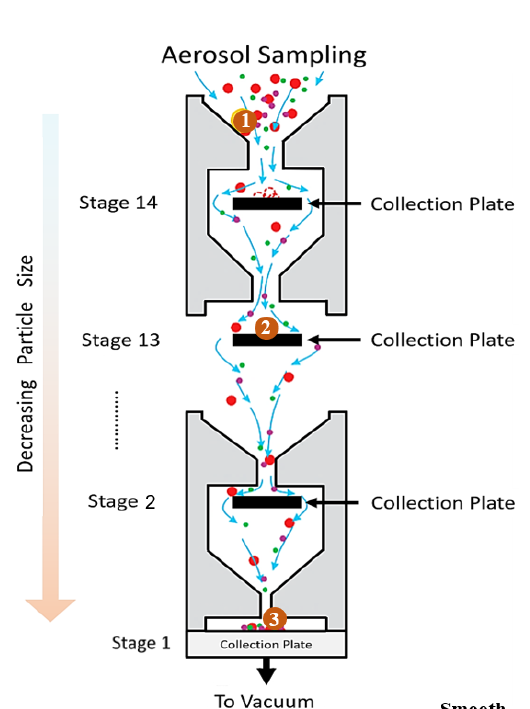
Figure 1. Schematic (not to scale) of ELPI stages with smooth alu- minum surfaces showing the 14 active collection/impaction plates corresponding to decreasing particle sizes starting from the top where aerosols first enter the impactor. The collection plate is also referred to as the filter stage (stage 1). The large circle labeled with “1” is a solid particle entering the ELPI. It moves through the ELPI and impacts at position “2” but rebounds and continues onward and rebounds off subsequent stages until detected at po- sition “3” on the lowest stage. Not shown: unipolar charging of aerosols, which occurs immediately after aerosols enter the instru- ment.